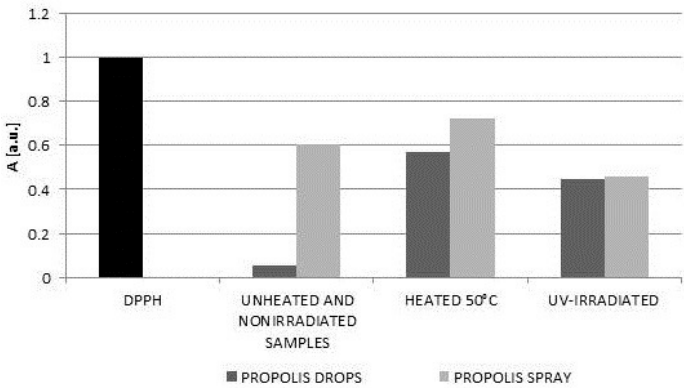
Figure 7. Comparison of the amplitudes (A min ) ( ± 0.01 a.u.) of EPR lines of DPPH in contact with drops and spray containing propolis for: the unheated and non-irradiated samples, the heated samples, and the UV-irradiated samples. The data for interaction time of DPPH with the propolis samples equal 60 min.